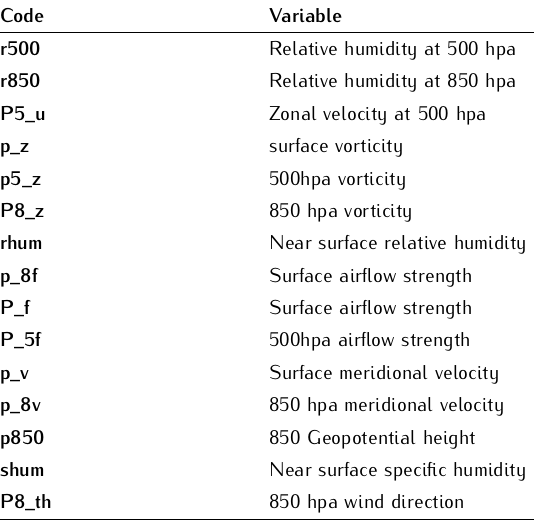
Table 2. Definition of the selected climate variable. Table 3. Statistical properties of ANN downscale model during calibration and validation